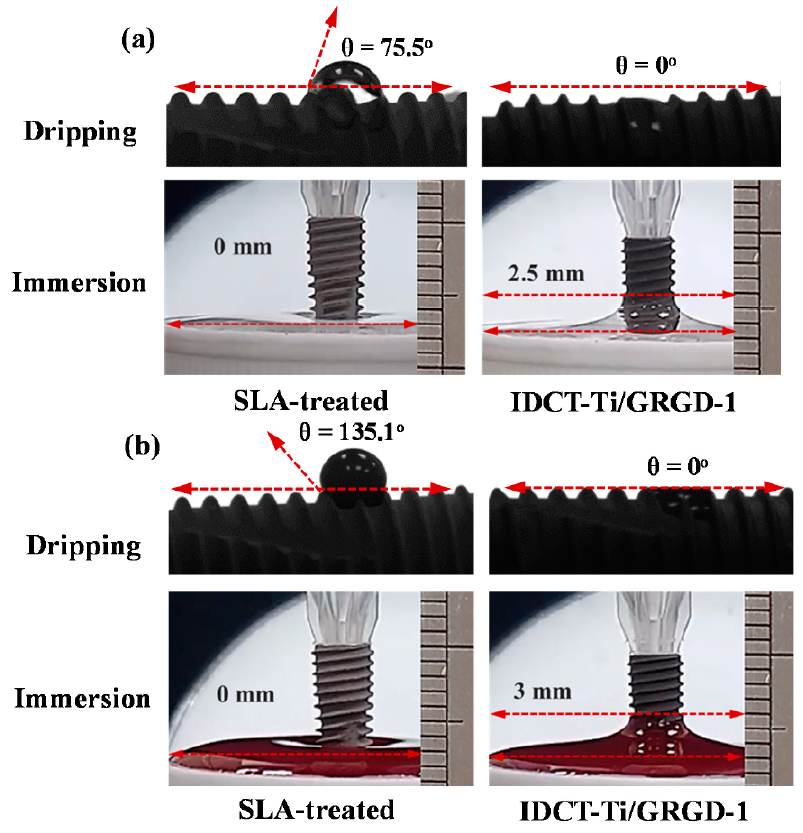
Figure 5. Wettability of the SLA-treated and IDCT-Ti/GRGD-1 implants under the dripping and immersion test: ( a ) deionized water test and ( b ) blood test.